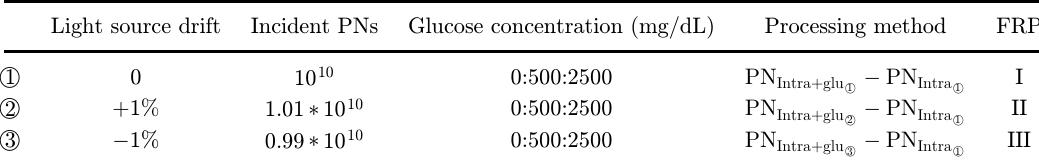
Table 4. Error analysis method of light source drift.